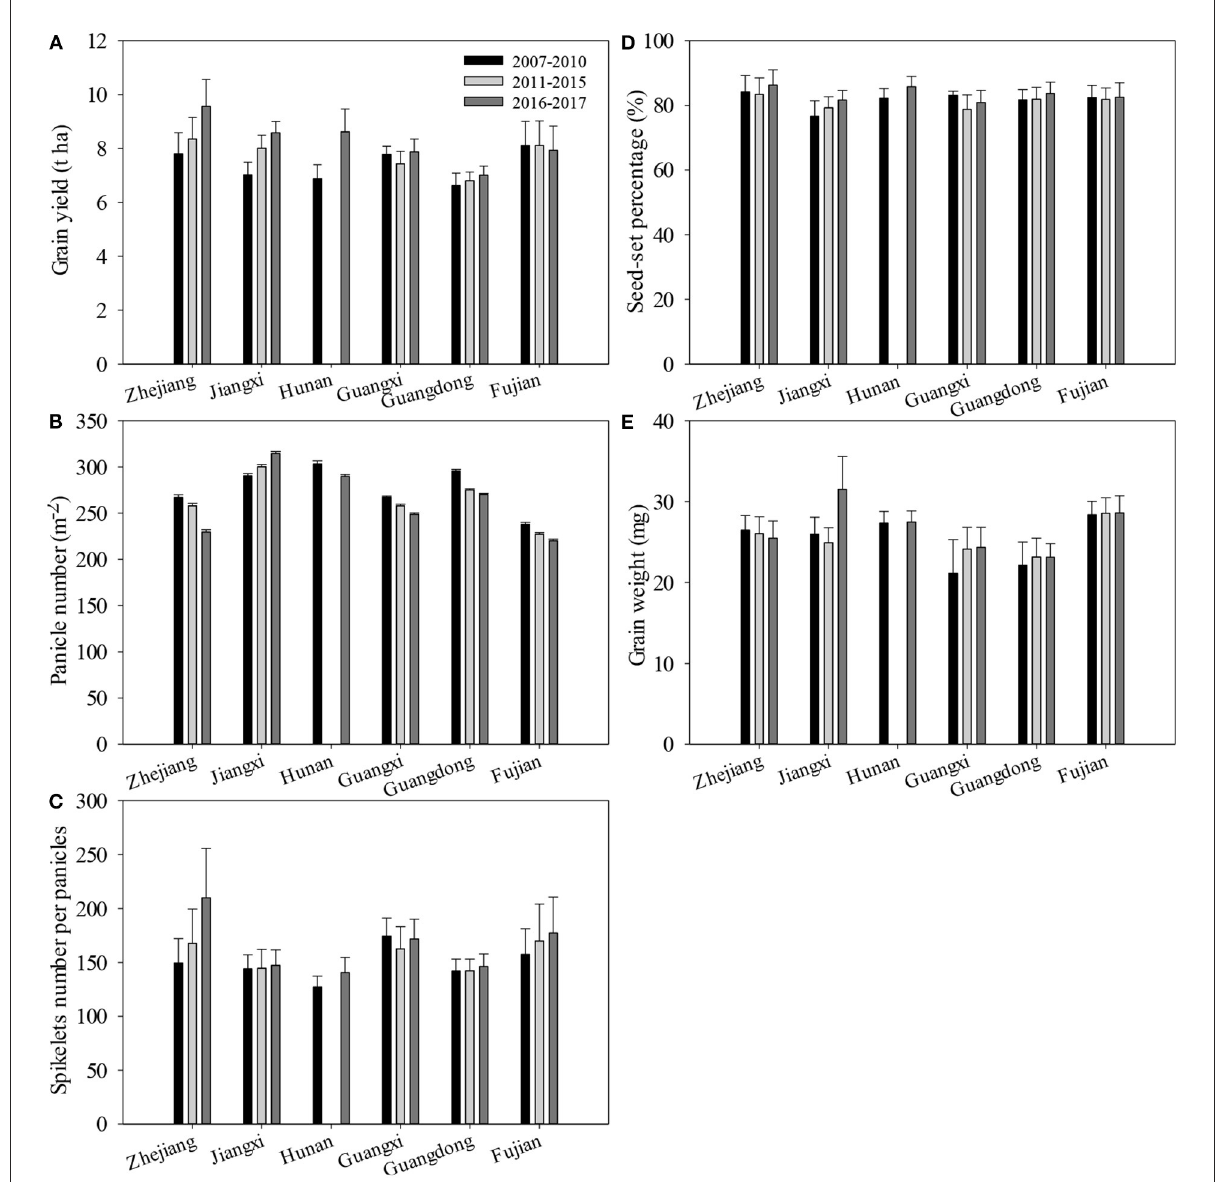
FIGURE1 Grain yield (A) , the number of panicles (B) , the number of spikelets per panicles (C) , seed-set percentage (D) , and grain weight (E) of high grain quality rice varieties in six provinces.